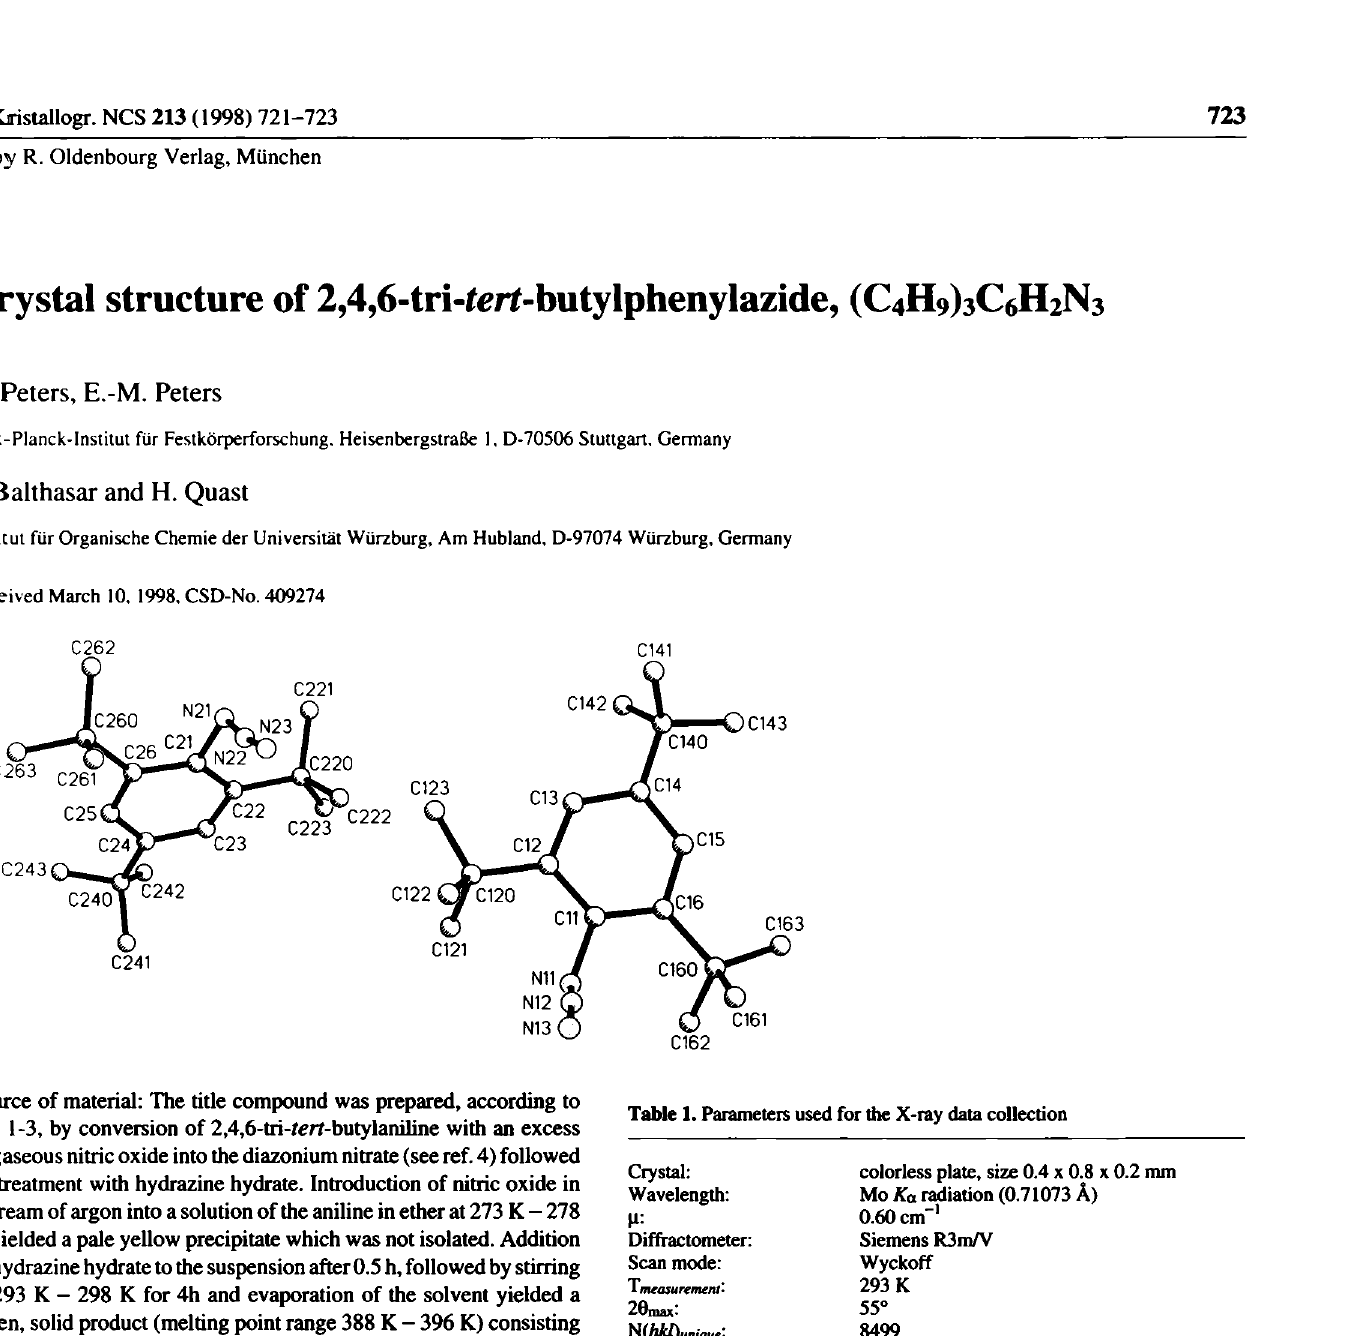
Table 2. Final atomic coordinates and displacement parameters (in